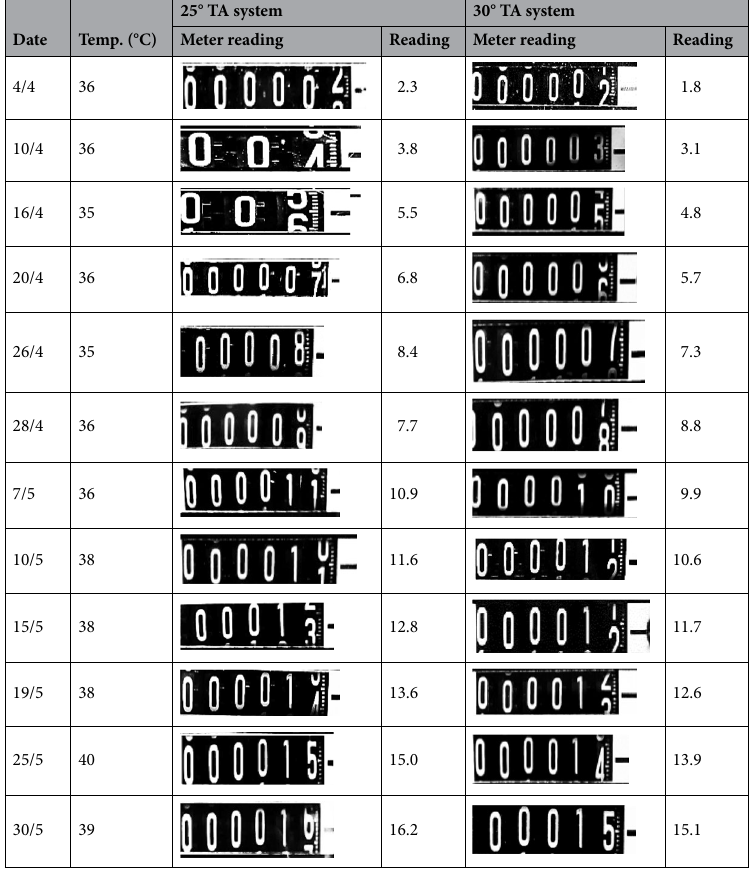
Table 6. Readings of the two TAs PV systems.